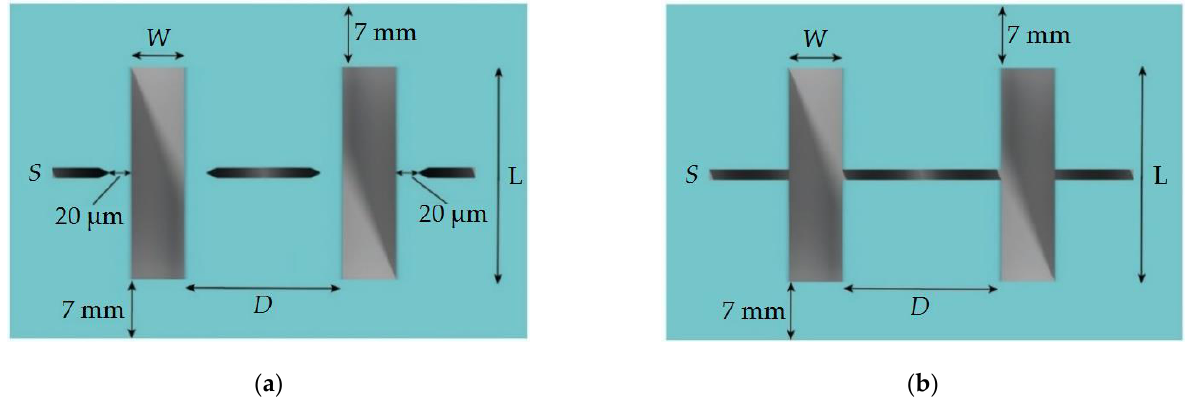
Figure 7. Typical dimensions of the test topology: ( a ) Dashed auxiliary lines; ( b ) Transverse crossing auxiliary lines.